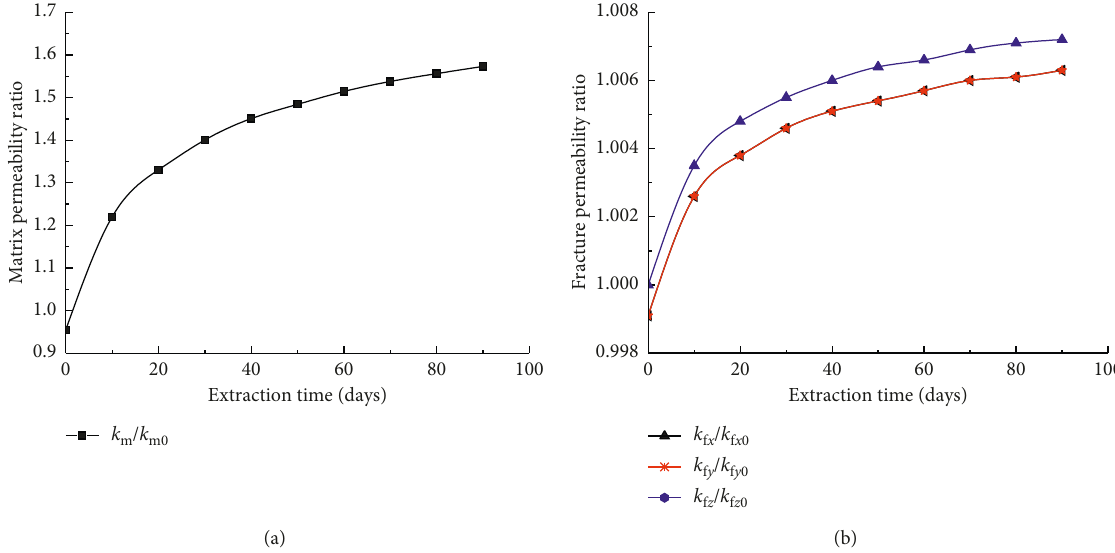
Figure 10: Permeability evolution with the anisotropic coefficient λ � 0.6. (a) Matrix permeability. (b) Fracture